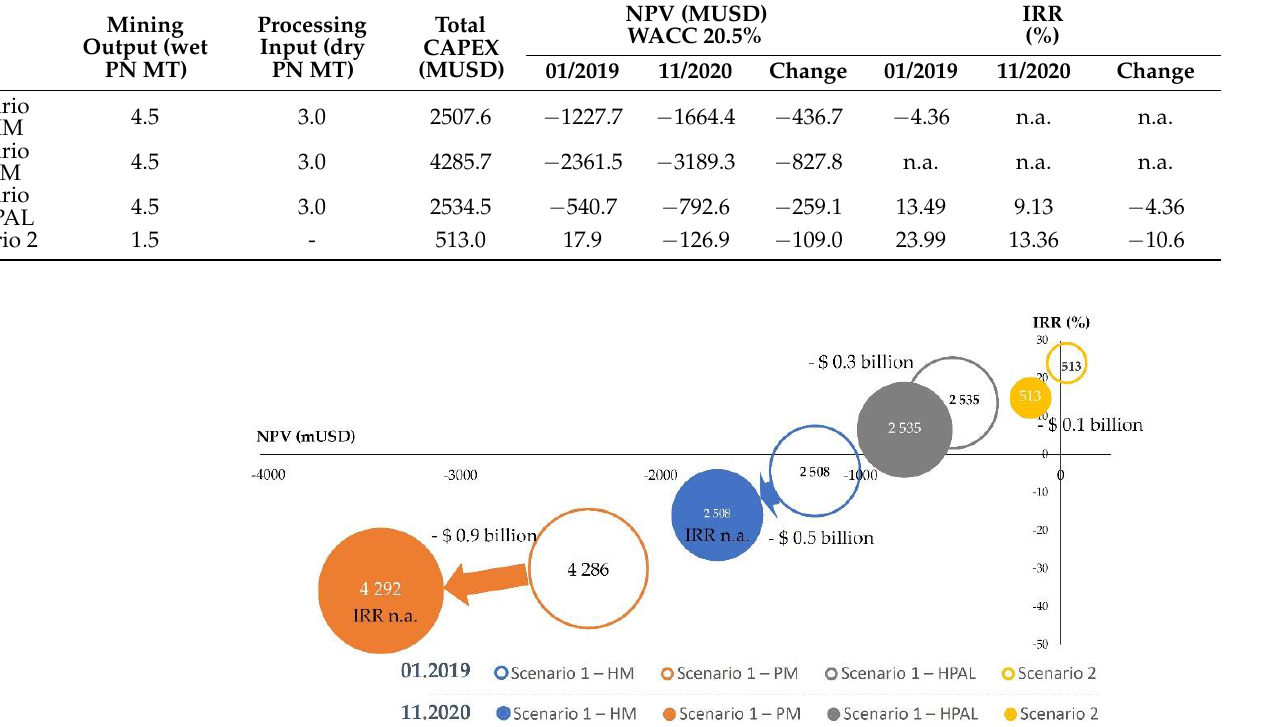
Figure 12. Comparison of the profitability of alternative investment options in 2019 and 2020.